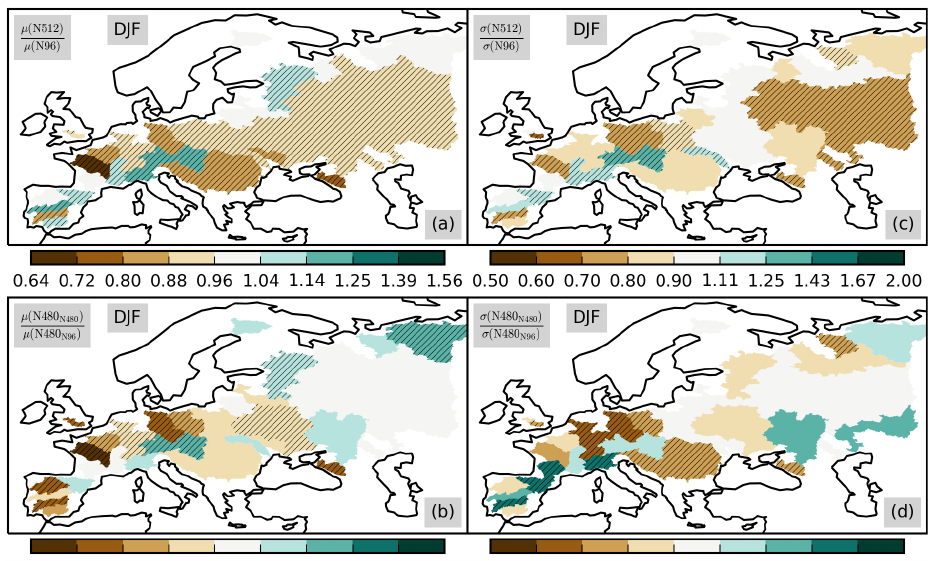
Figure 10. Winter (December–February) ratios of fitted GEV parameters for (a, b) the location parameter µ and for (c, d) the scale parameter σ , between (a, c) the N512 and N96 simulations and between (b, d) the N480 control simulation and the N480 simulation with N96 orography. Hatching shows statistically significant